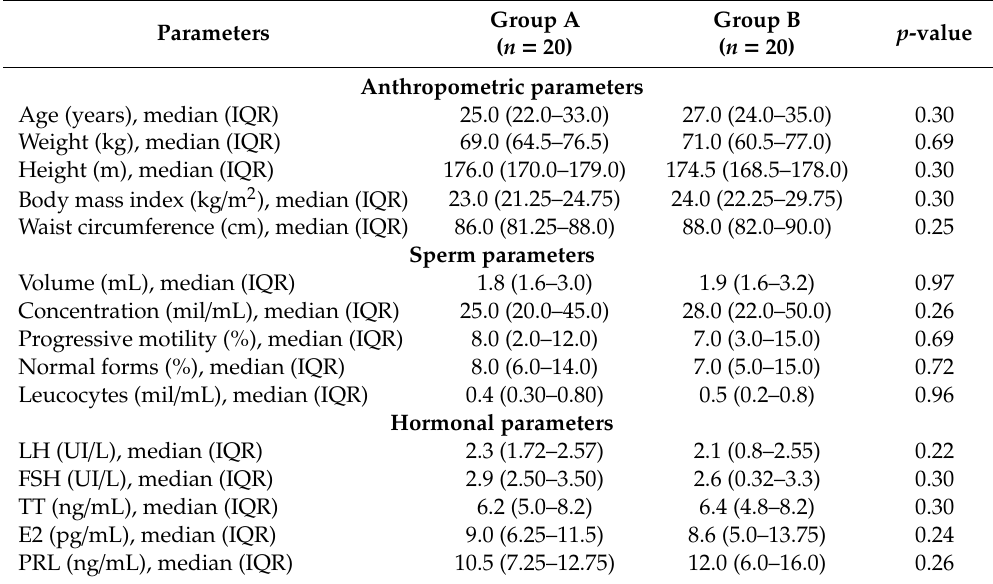
Table 1. Anthropometric, seminal, and hormonal characteristics of patients at enrollment.